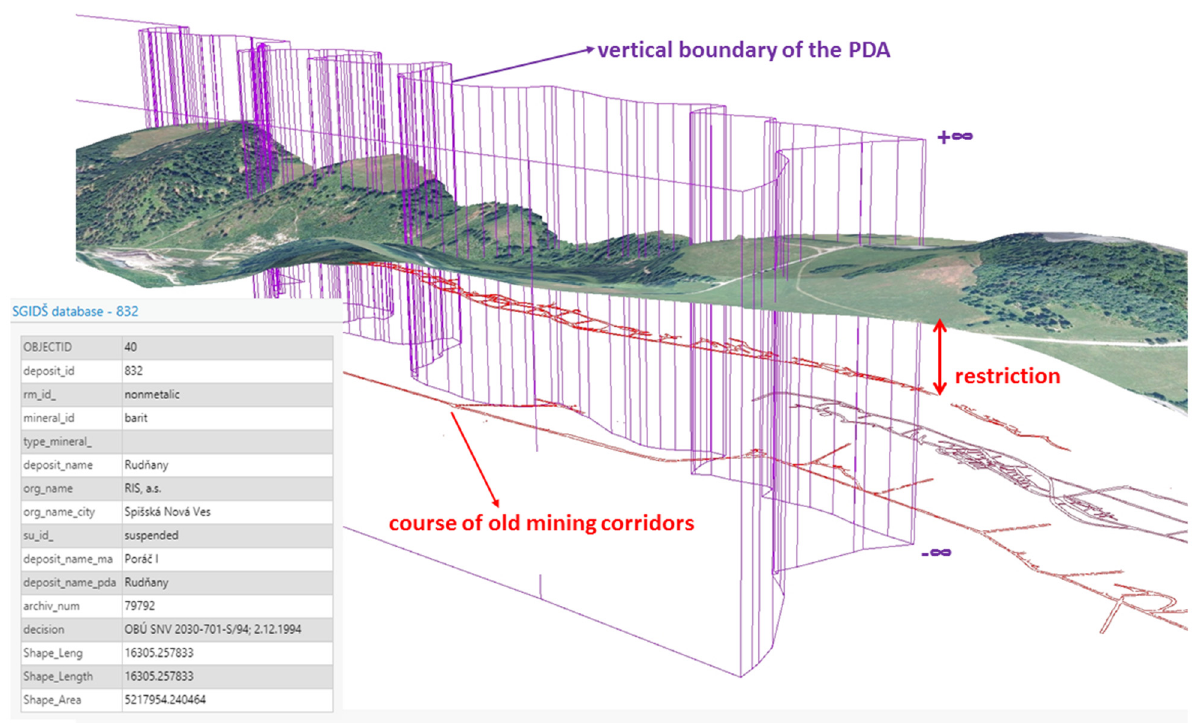
Figure 12. 3D model of the PDA object in c.u. Rud ň any.